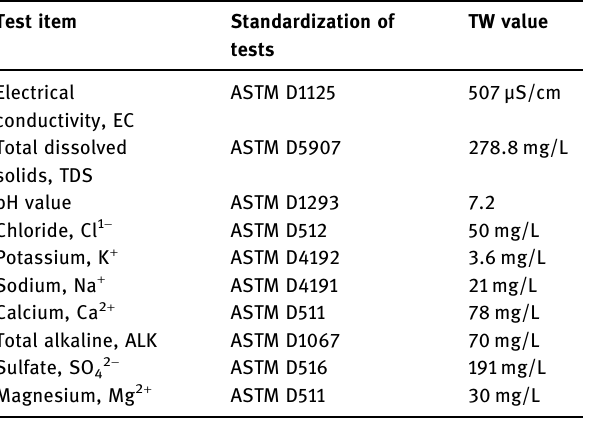
Table 1: Water testing methods and requirements ( quality tests of TW )